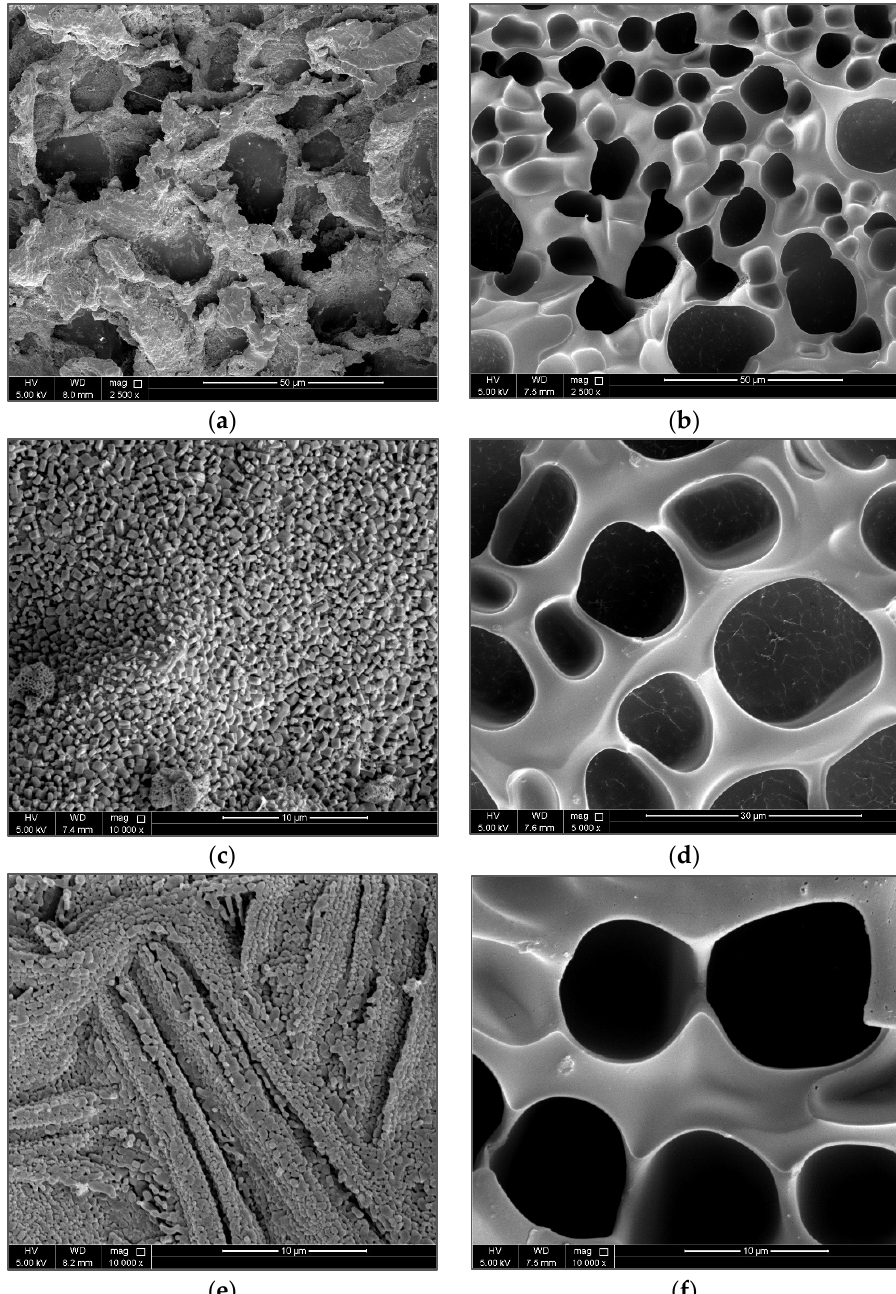
Figure 11 . SEM images of different magnifications for PAM 3.5% /Cs 0.5% in ( b , d , f ) distilled water; and ( a , c , e ) high saline solution.